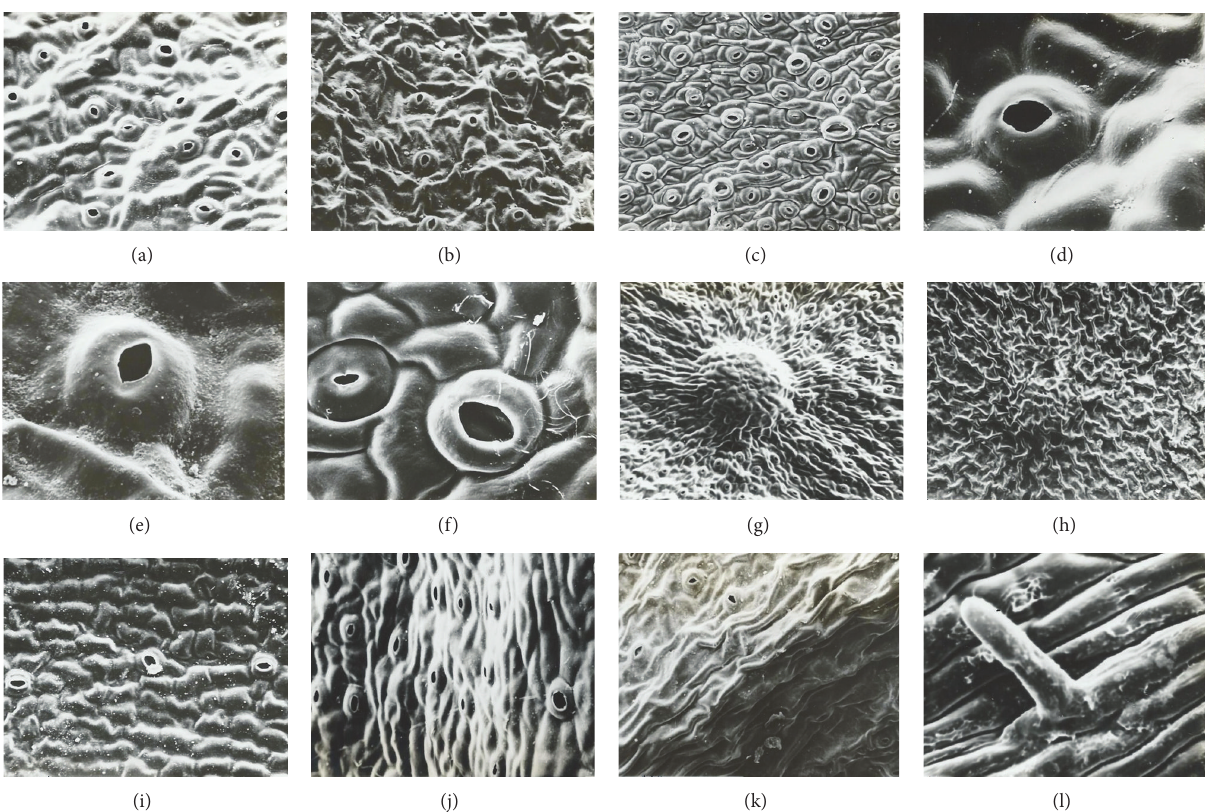
Figure 2: Scanning electron micrographs (SEM) of in vivo and in vitro grown Citrus assamensis leaves. (a) Abaxial surface of in vitro and (b) in vivo grown leaf showing anomocytic stomata; (c) abaxial surface of in vitro grown leaf, showing vivid anomocytic stomata in between lined epidermal cells; (d-e) abaxial surface of in vivo grown leaf showing clearly defined anomocytic stomata that appeared from the epidermal surface; (f) stoma of in vitro grown leaf sunk into epidermal surface; (g-h) abaxial surface of in vivo grown leaf, showing the presence of oil glands; (i) abaxial surface of in vitro grown leaf showing the absence of oil gland; (j-k) lack of trichomes was observed from primary veins of in vivo grown leaf; (l) primary vein of in vitro grown leaf showing the presence of trichome.